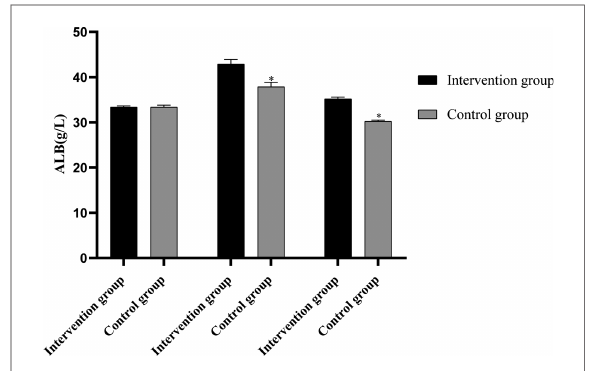
FIGURE 3 Comparison of ALB levels between the two groups before and after intervention (Note: compared with the intervention group, * P < 0.05).